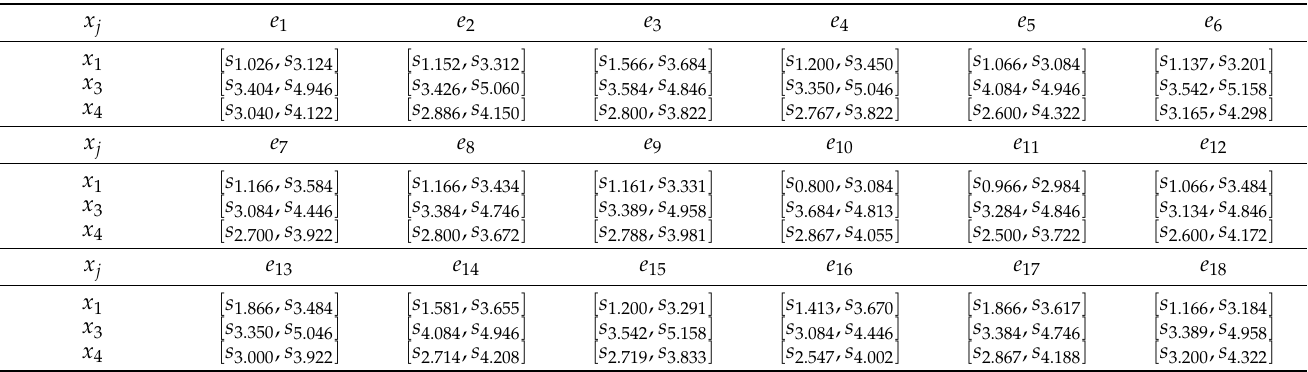
Table 6. The upper bound of the first round of adjustment opinions.